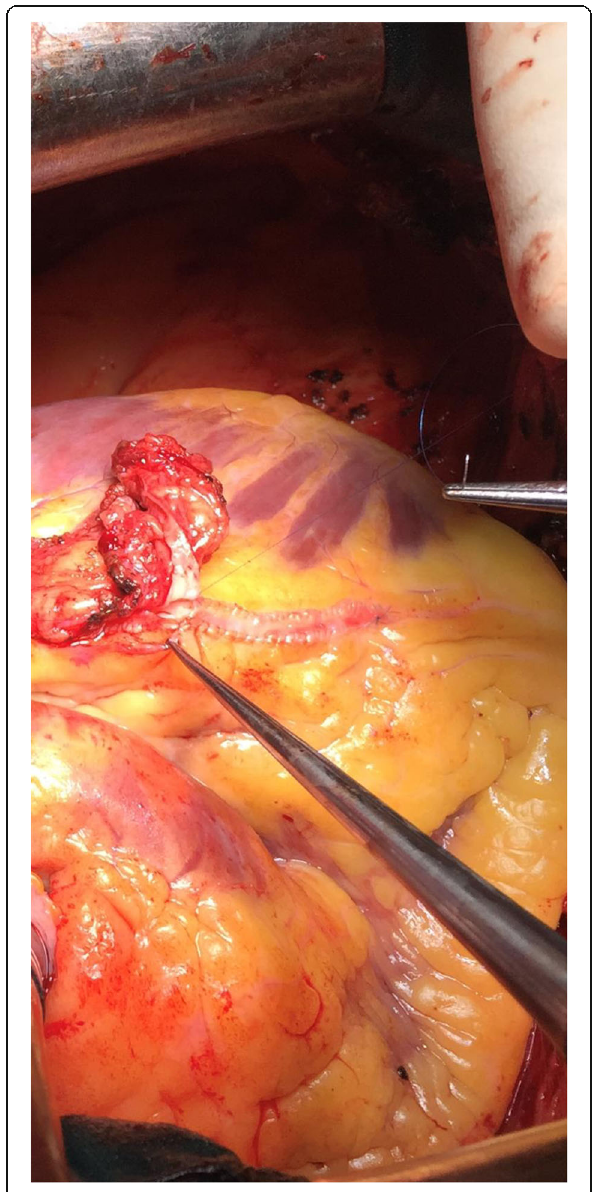
Fig. 2 Left internal mammary artery anastomosis to a long saphenous vein patch on the left anterior descending